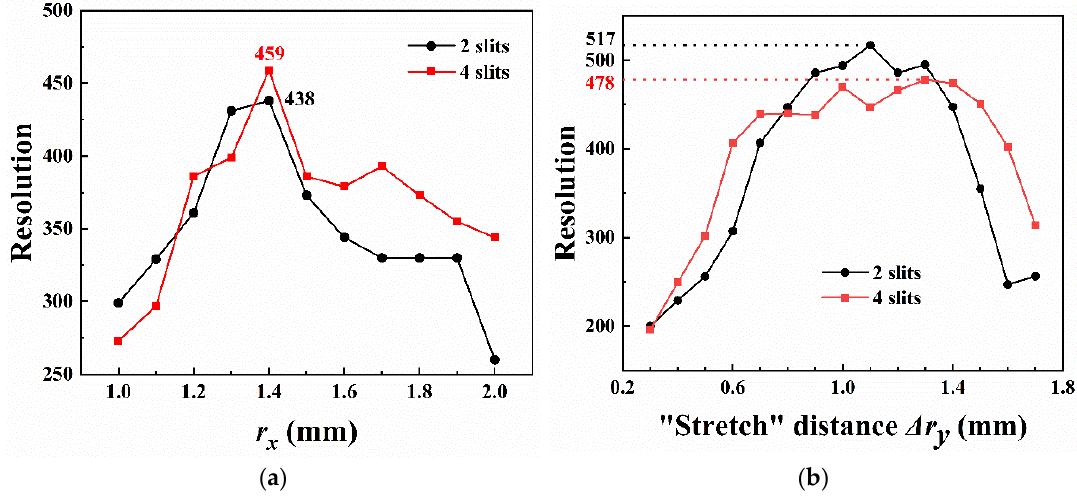
Figure 2. ( a ) Trends of mass resolution with r x at Δ r y = 0.75 mm; ( b ) trends of mass resolution with Δ r y at r/r x = 2/1.4. Appropriate field radius r x and “stretch” distance Δ r y led to better resolutions.